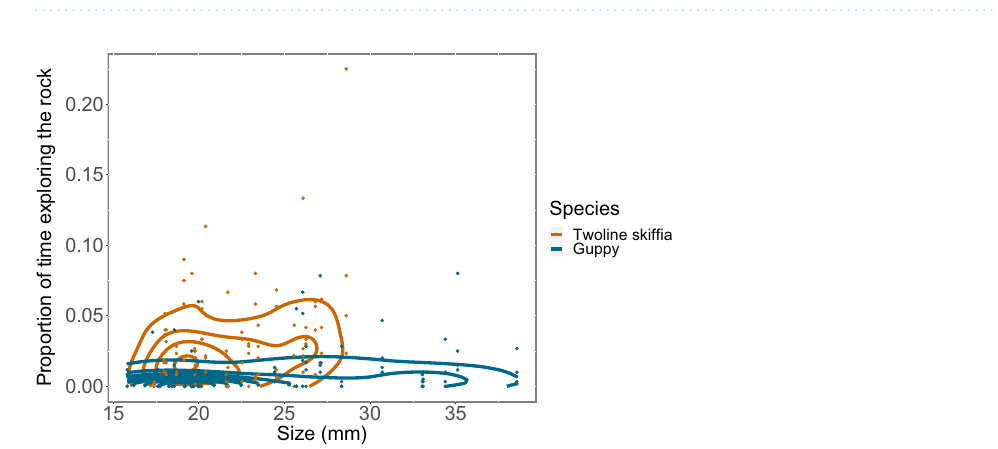
Figure 2. Proportion of the total time observed (600 s) guppies of different sizes used the rock as refuge in the temperature gradient.